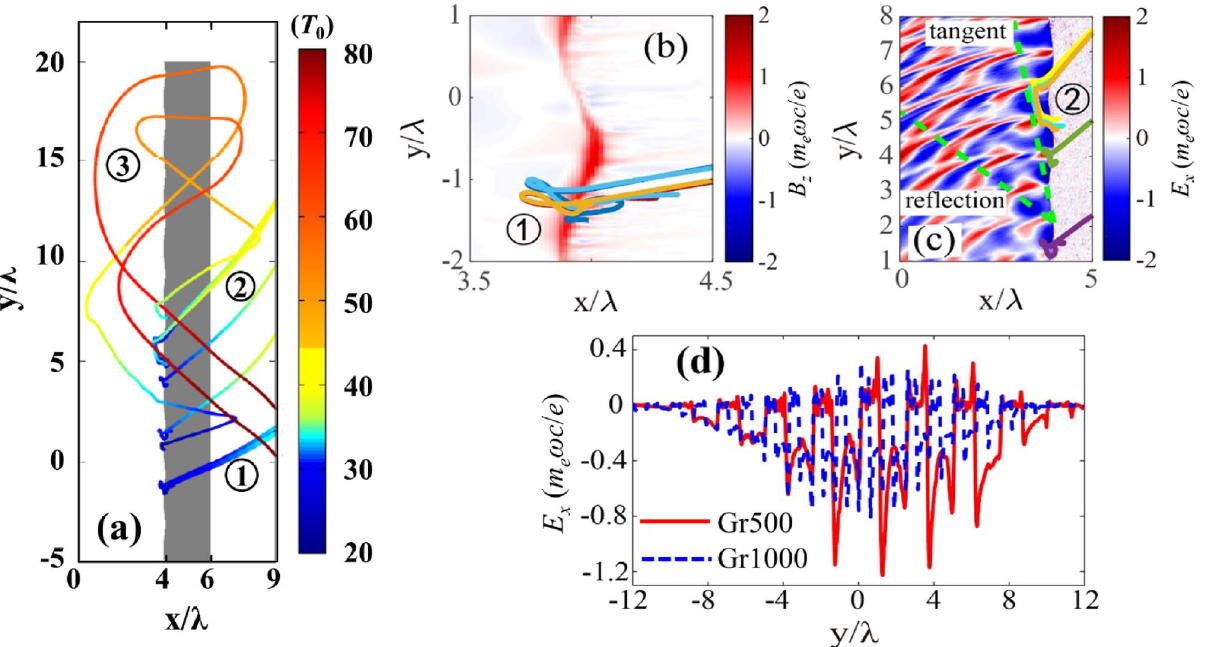
Figure 6. ( a ) Trajectories of fast electrons in the three distinguished stages of laser pulse irradiation. The colorbar represents the simulation time ( T 0 ). Stage 1: 0—35 T 0 , Stage 2: 36—60 T 0 , Stage 3: 61—100 T 0 . ( b ) Quasi- static magnetic field B z at t = 25 T 0 and two selected electron trajectories around this time. ( c ) The transient field E x at t = 35 T 0 and four selected electron trajectories around this time, where an electromagnetic field component is shown to propagate along the tangent direction in addition to the reflected laser (green dashed line). ( d ) Surface electric field E x for Gr500 and Gr1000 at t = 30 T 0 , the moment at which the laser peak impinges on the target. B z and E x are normalized by m e ωc / e